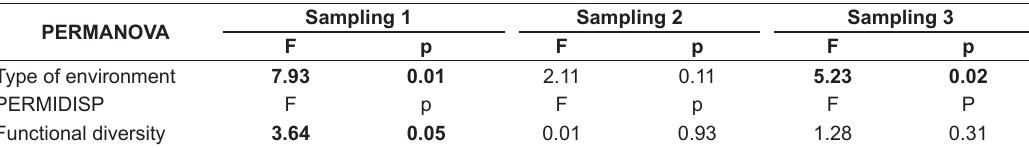
Table 5. PERMANOVA F and p values based on Bray-Curtis distance for functional composition (CWM values for functional traits related to feeding mode, trophic group, habitat and body size) and statistic parameters of Permutation test for homogeneity of multivariate dispersions (PERMIDISP) based on PERMANOVA for functional composition. Numbers in bold mean significant values. In both tests 999 permutations were